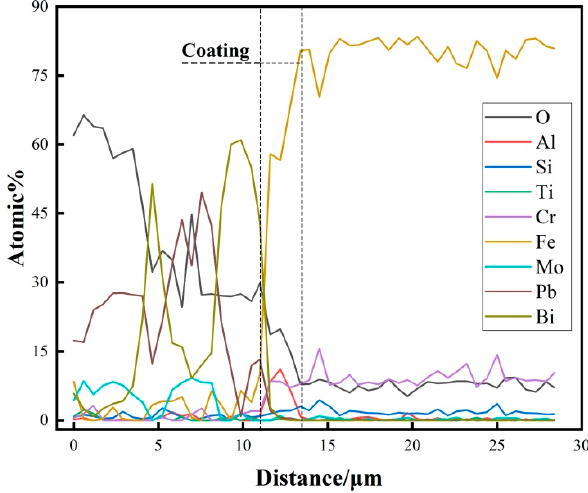
Figure 12. EDS line scanning of the AlTiCrFeMoSi HEA coating exposed to LBE at 550 °C for 2000 h.